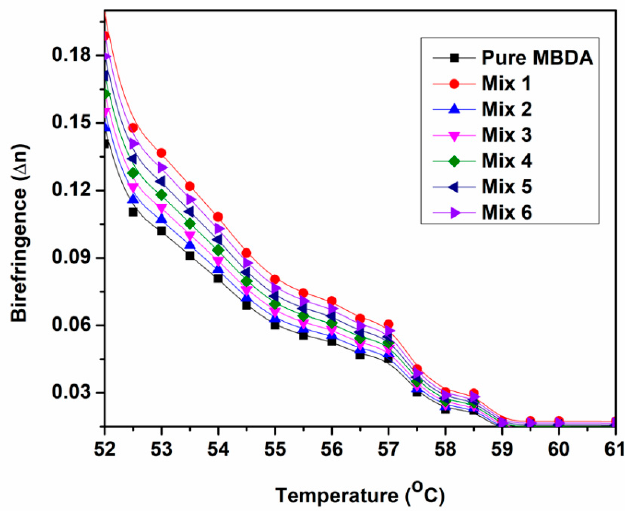
Figure 11. Variation of birefringence with temperature for pure nematic MBDA and its mixture with core/shell quantum dots (Mix 1 to Mix 6).